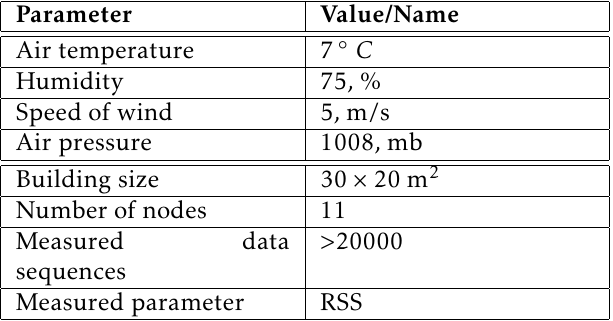
Table 2. Weather and experiment setup.